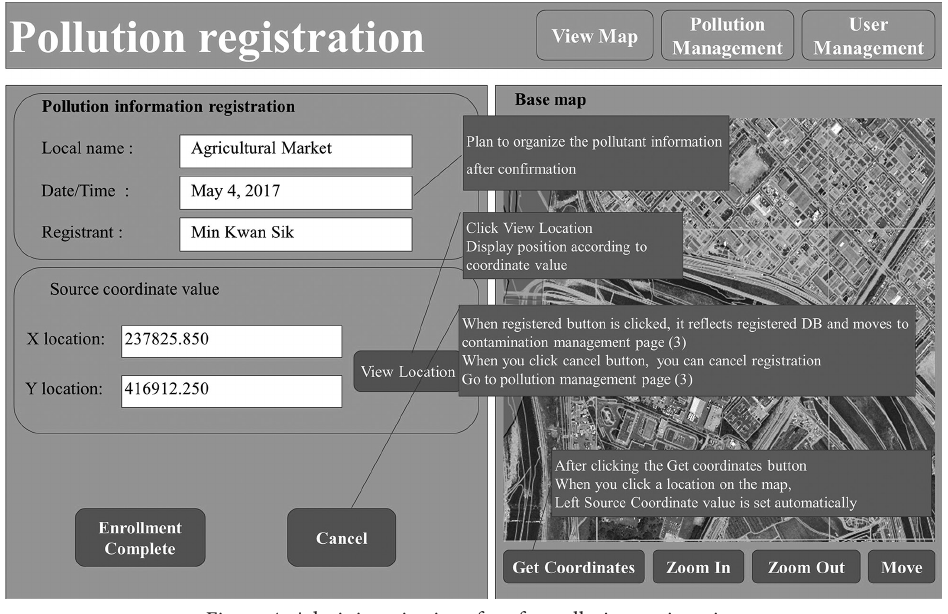
Figure 4. Administrative interface for pollution registration